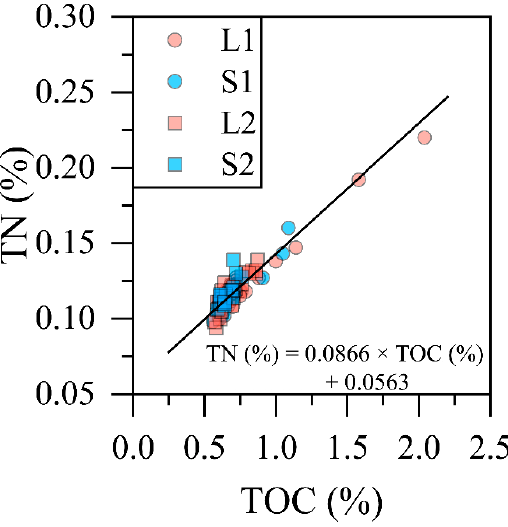
Figure 5. The plot of TOC versus TN for all subsamples along the sediment cores. Solid line is the geometric mean regression line for all subsamples.